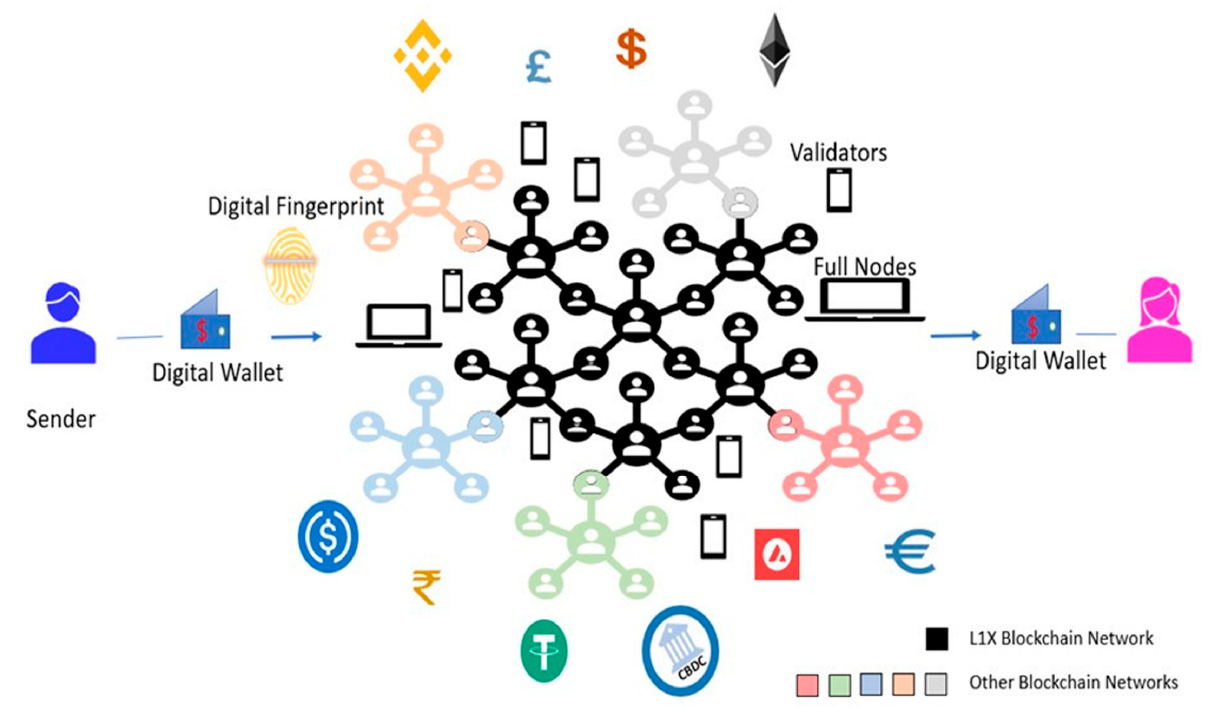
Figure 8. L1X conceptual framework .